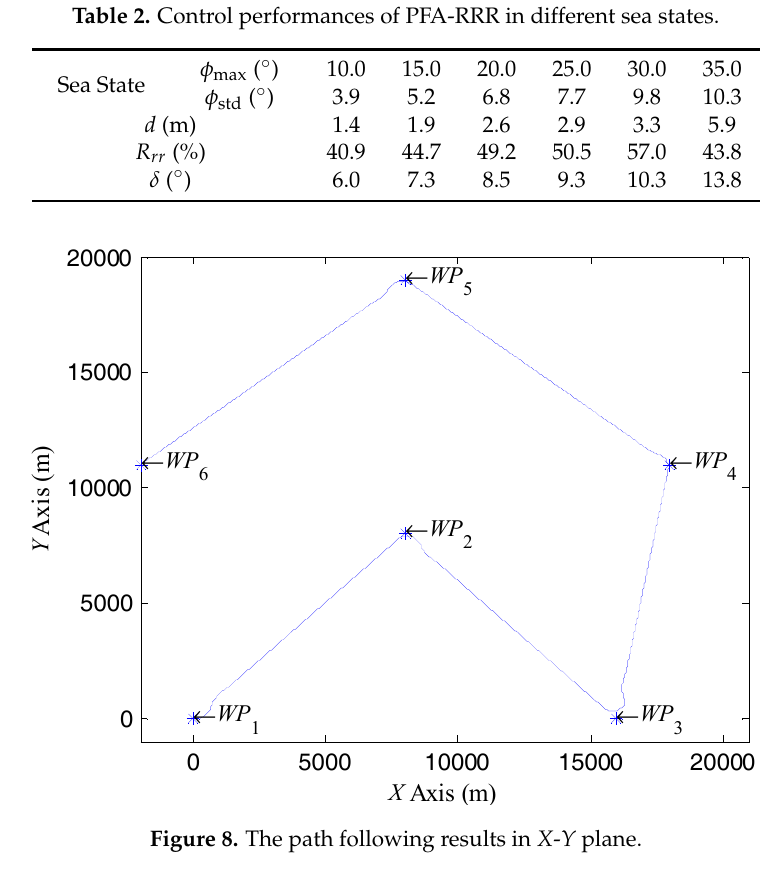
Figure 9. The contrast experimental results of LOS-CT and LOS between WP 1 and WP 2 .